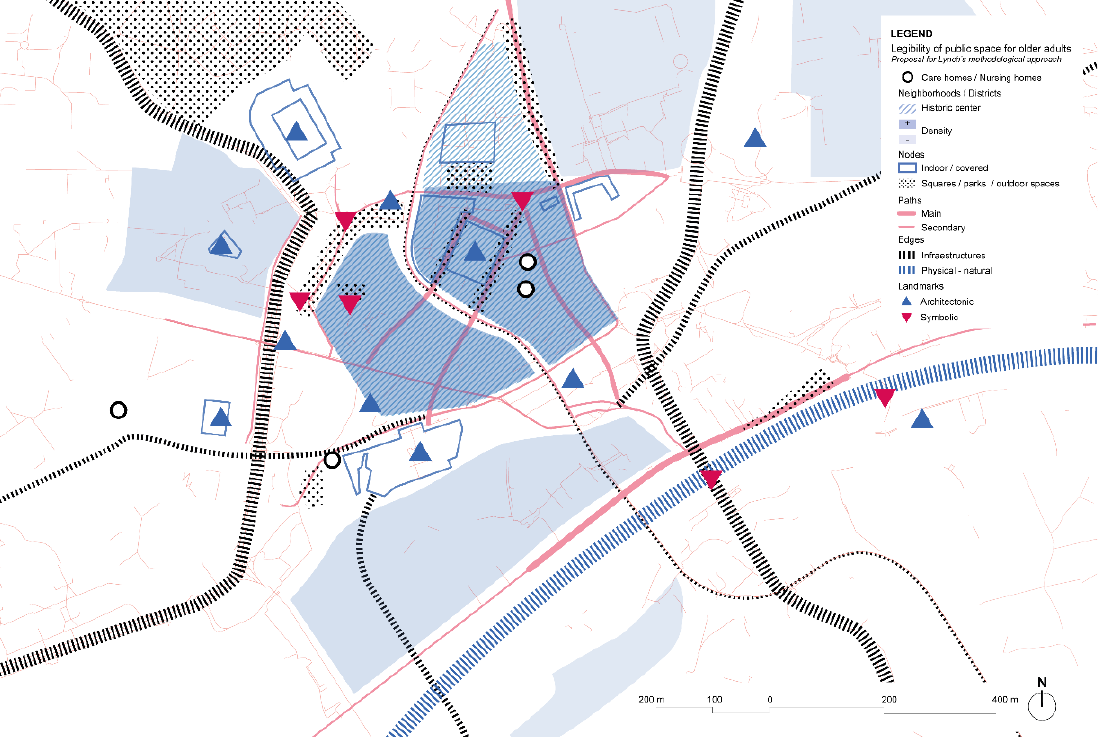
Figure 4. Newcastle city-center’s scheme based on Lynch’s theory. Source: Own elaboration.